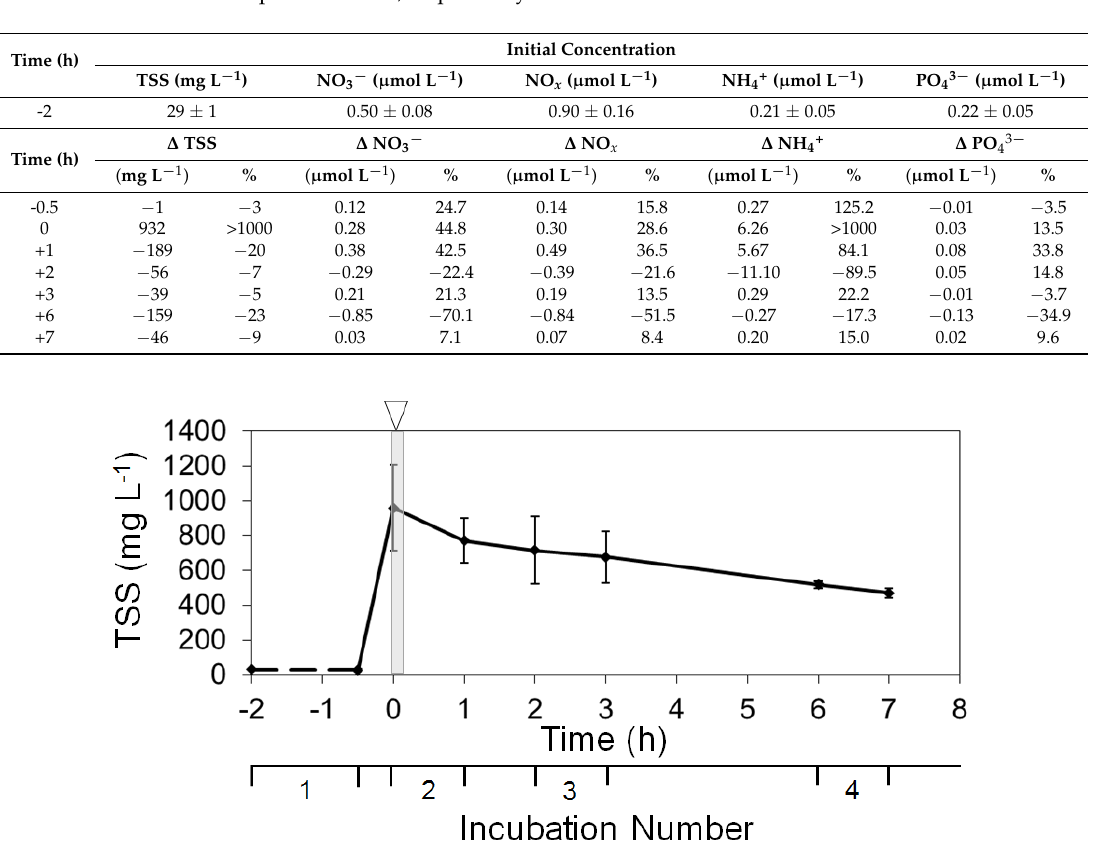
Table 3. Time-series of mean changes ( n = 6) in total suspended sediment and dissolved inorganic nutrient concentrations according to mesocosms sampling timeline. Negative times represent before, time 0 represents immediately prior to, and positive times represent hours after the sediment disturbance and resuspension event, respectively.